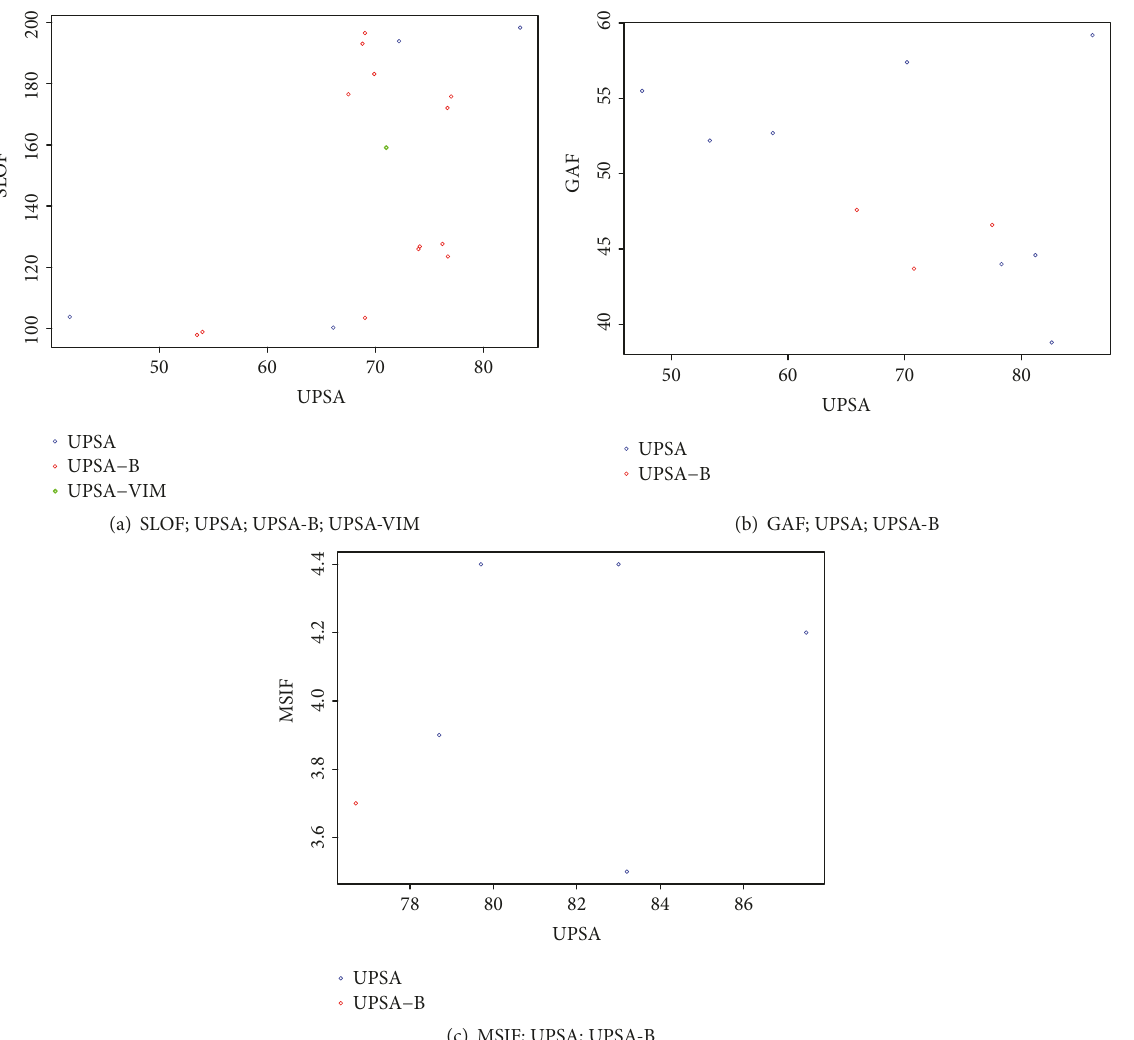
Figure 2: Scatterplot of UPSA and scores on functional measures from studies that reported both